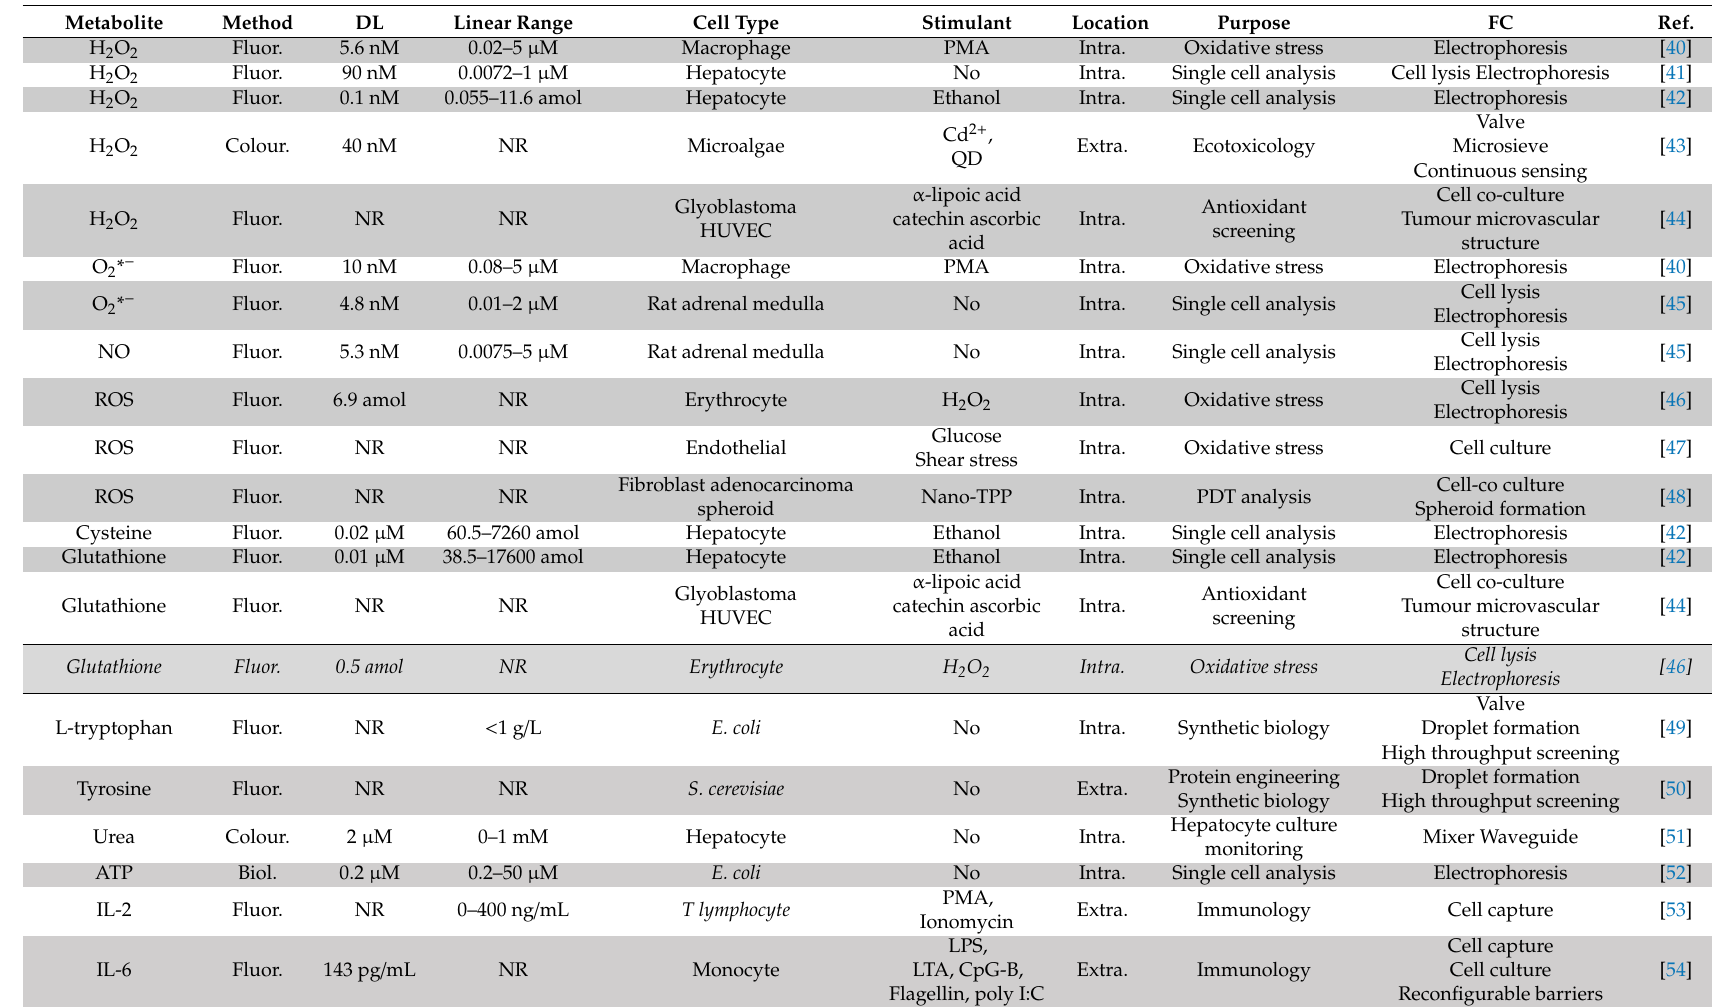
Table 1. LOC systems used for optical metabolite detection.